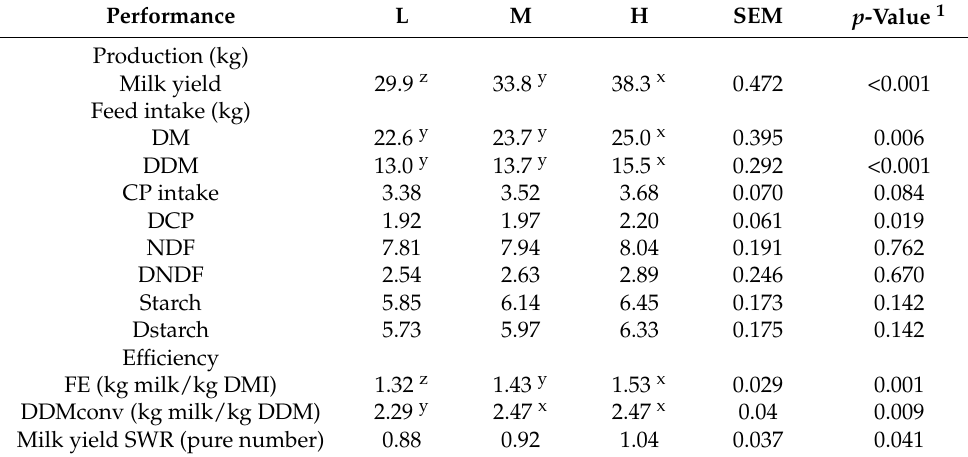
Table 5. Average performance, expressed as production, feed intake, efficiency and summer–winter ratio (SWR) in farms belonging to low (L), medium (M) and high (H) production